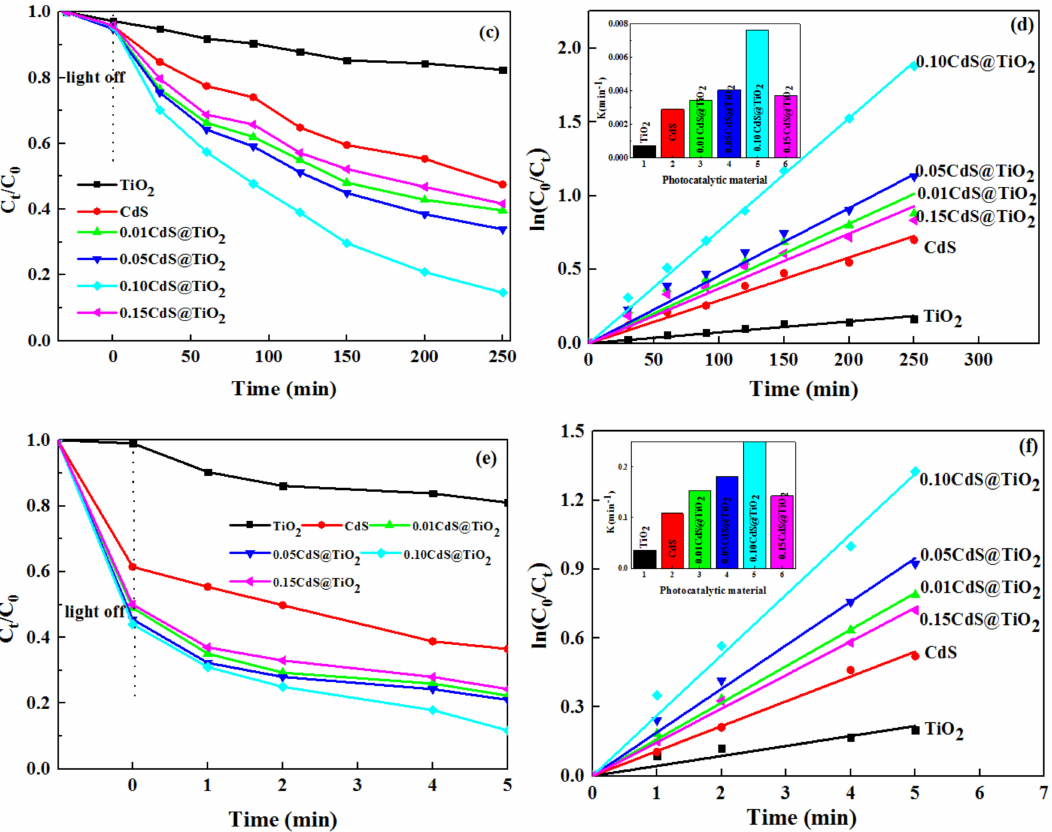
Figure 4. Photocatalytic degradation of MB ( a ), RhB ( c ), TCH ( e ) and kinetic rate constants for the degradation of MB ( b ), RhB ( d ), TCH ( f ); where C t is the concentration after different light irradiation time and C 0 is the initial